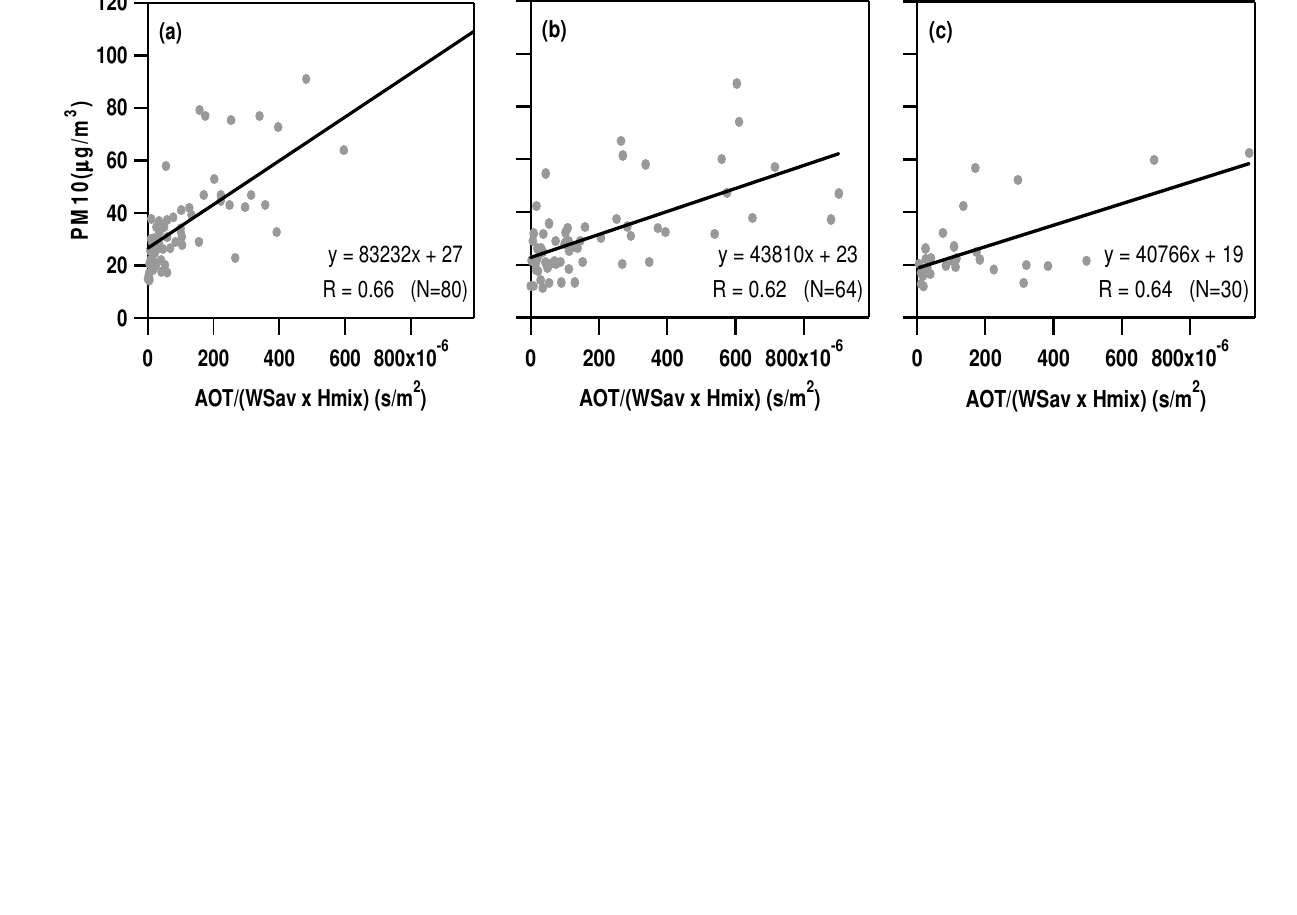
Figure 15. Scatterplot of Guagnano-PM10 mass concentrations versus clear-sky AOTs divided by the (WSav × Hmix) product for (a) 2006, (b) 2007, and (c) 2008. Slope, intercept and linear correlation coefficient ( R ) are also given in each plot in addition to the total number of data points ( N